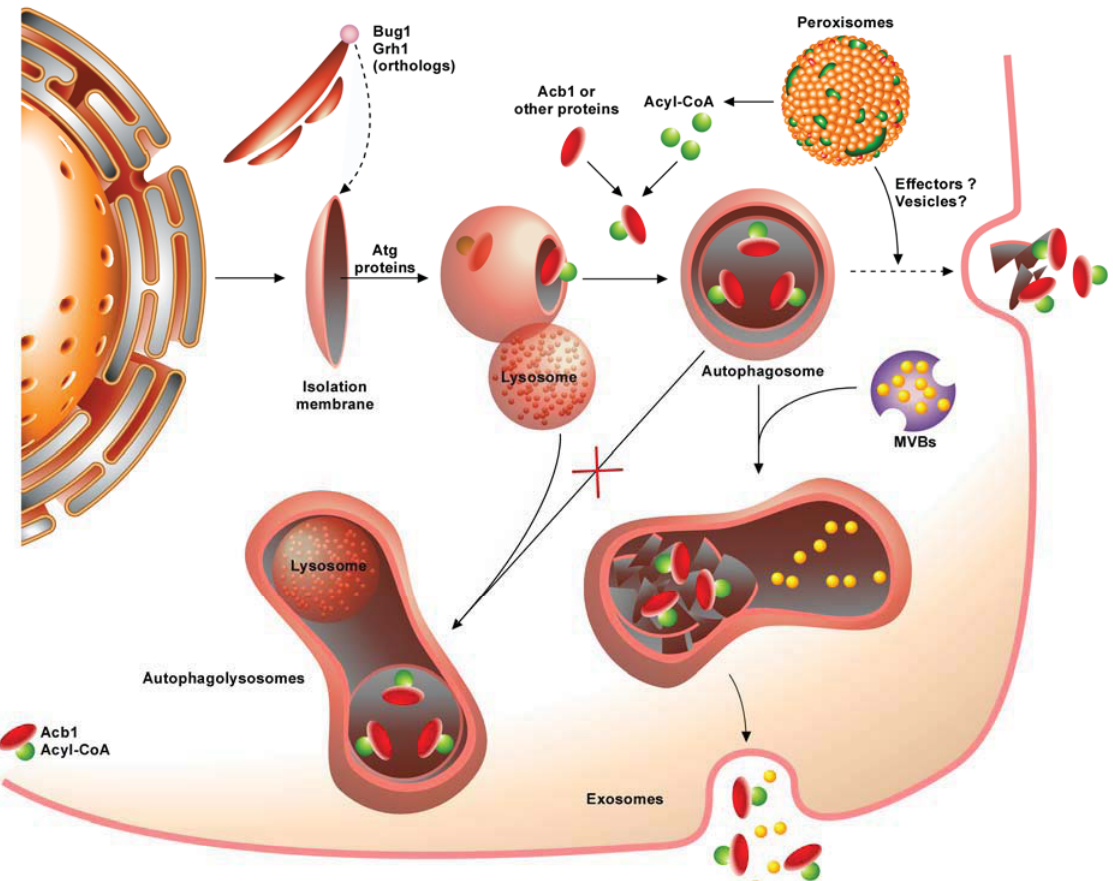
Figure 3. Mechanisms involving autophagy and unconventional protein